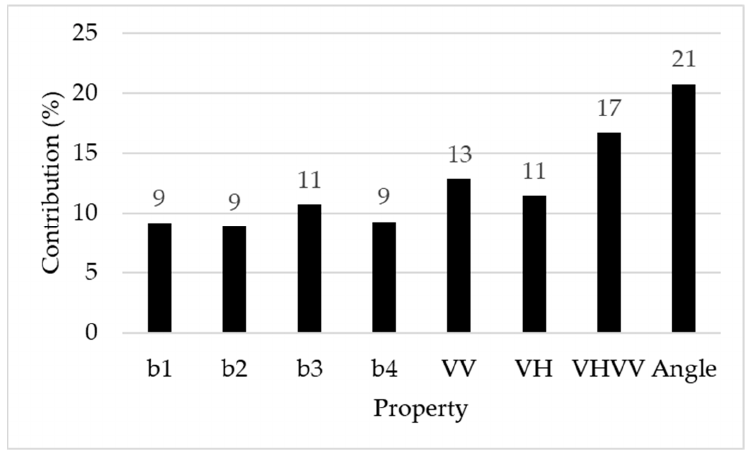
Figure 3. Feature importance in the classification model.